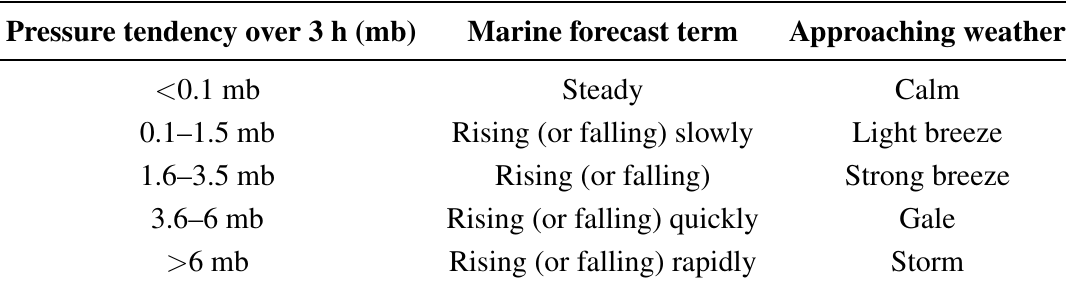
Table 1. Marine forecasting terminology for barometric pressure